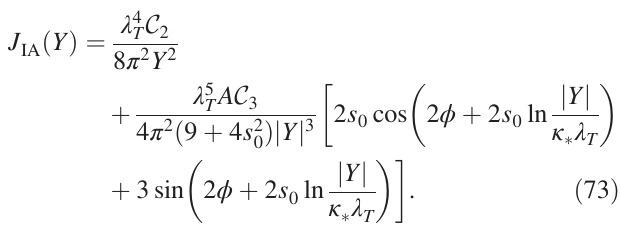
FIG. 9. (a) Impulse approximation Y -scaling function J red, orange, and green lines show the scaling function for three different values of the three-body parameter, κ comparison, we include the impulse approximation for the noninteracting gas at the same temperature. (b) The impulse approximation shows heavy tails for large Y , which are in good agreement with the leading-order two-body Tan relation and a subleading three-body correction. (c) The three-body tail is indicated by black dotted